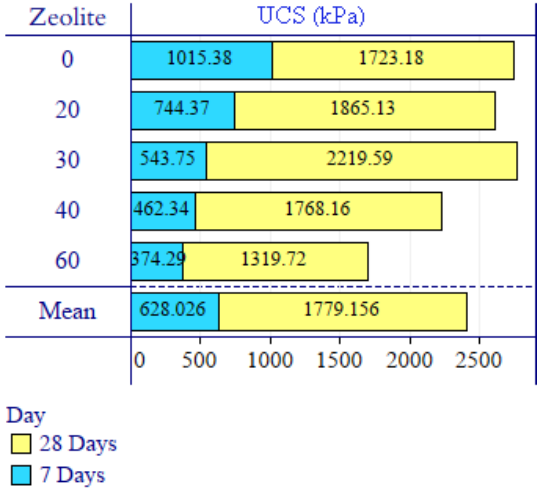
Figure 11. Data entered in statistical analysis. Table 7. The results of the two-factor analysis of variance for zeolite and day variables.